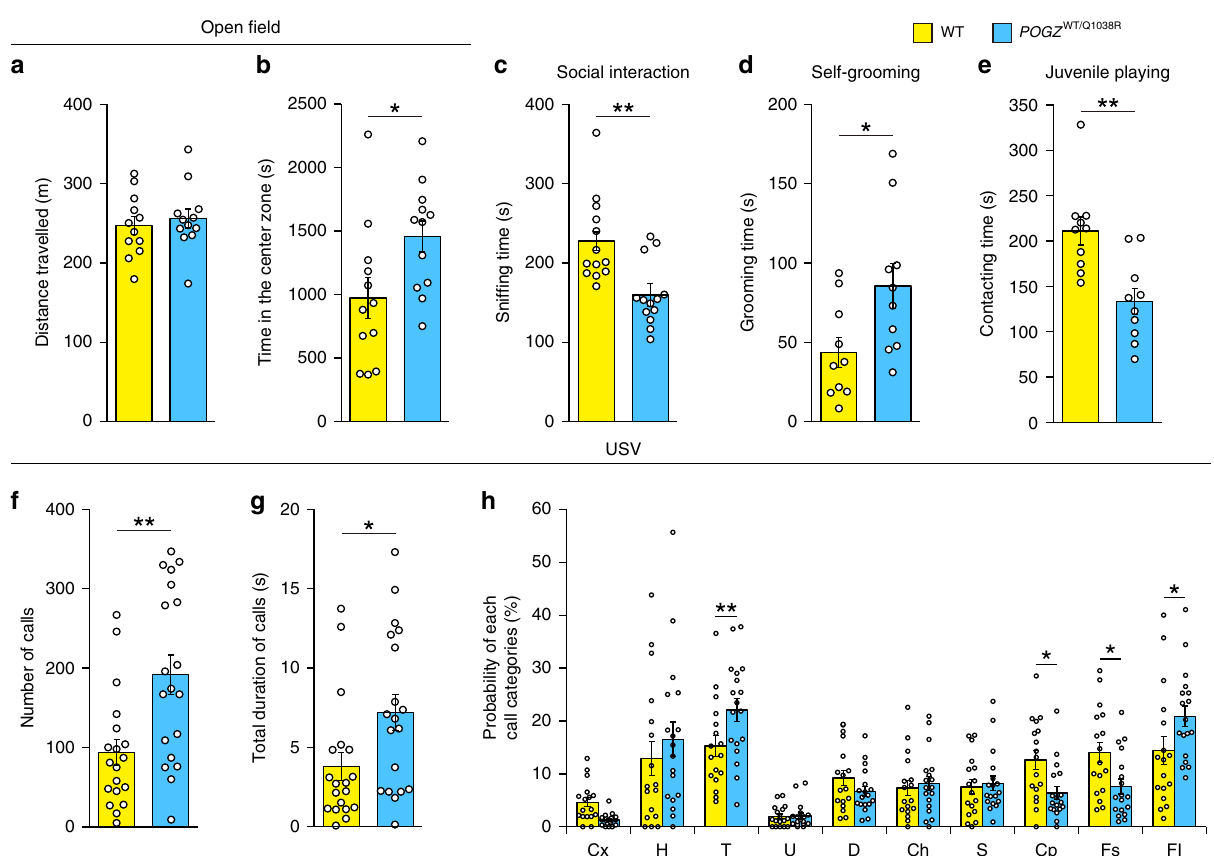
Fig. 5 NDDs-related behavioral abnormalities in POGZ WT/Q1038R mice. a Distance traveled in the open- fi eld test (each n = 12). b Time spent in the center zone in the open- fi eld test (each n = 12). c Time spent snif fi ng in the reciprocal social interaction test (each n = 13). d Time spent grooming in the self-grooming test (each n = 10). e Time spent contacting in the juvenile playing test (each n = 10). f Numbers of ultrasonic calls made by WT and POGZ WT/Q1038R mice at postnatal day 4 (each n = 19). USV ultrasonic vocalization. g Total duration of ultrasonic calls (each n = 19). h Altered ultrasonic call patterns in POGZ WT/Q1038R mice (WT, n = 17; POGZ WT/Q1038R , n = 18) (Cx complex; H harmonics; T two-syllable; U upward; D downward; Ch chevron; S shorts; Cp composite; Fs frequency steps; Fl fl at). WT wild-type. a – g One-way ANOVA; a F 1, 22 = 0.277; b F 1, 22 = 5.771; c F 1, 24 = 13.02; d F 1, 18 = 5.914; e F 1, 18 = 13.62; f F 1, 36 = 10.64; g F 1, 36 = 5.465. h Two-way repeated-measures ANOVA with Bonferroni – Dunn post hoc